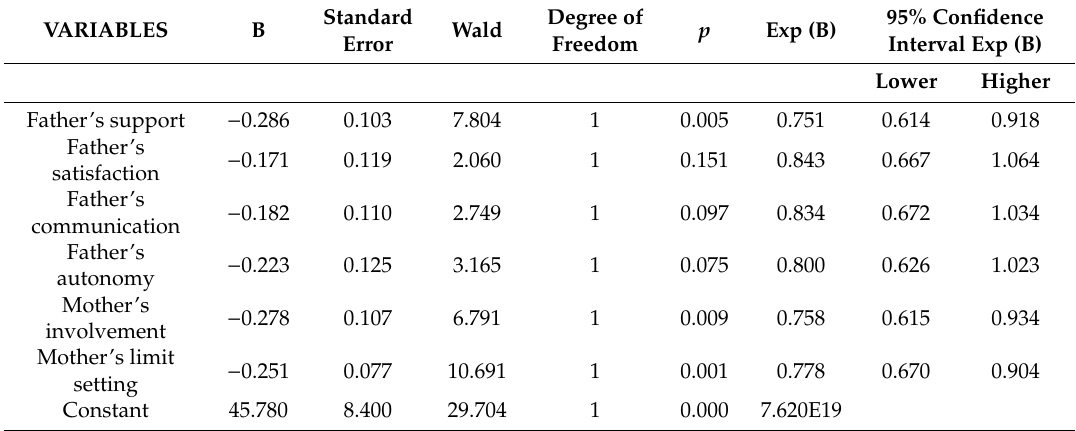
Table 2. Variables included in the